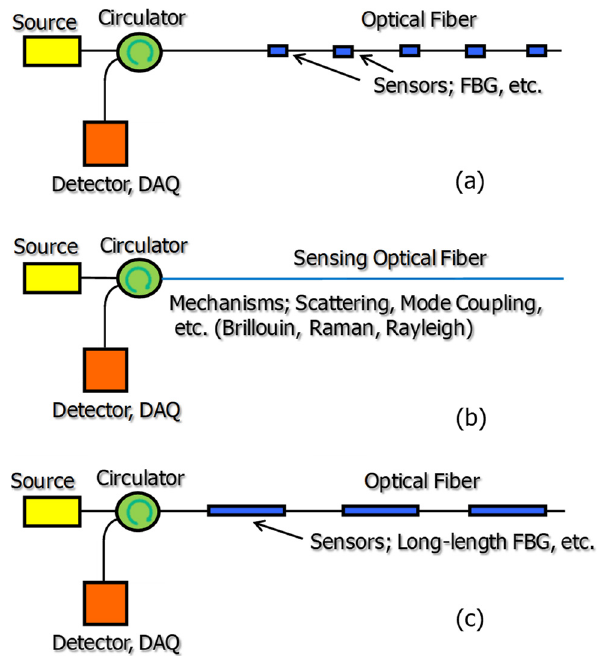
Figure 2. Varieties of fiber optic nerve systems. ( a ) Multiplexed fiber optic sensing; ( b ) distributed fiber optic sensing; and ( c ) quasi-distributed fiber optic sensing.